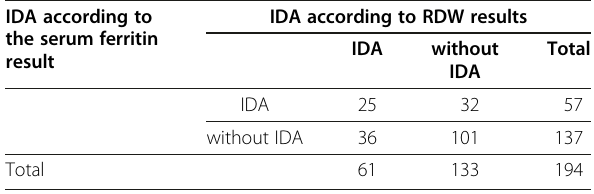
Table 2 Results of RDW compared with serum ferritin levels for diagnosis of IDA among pregnant women at Khartoum Hospital, Sudan